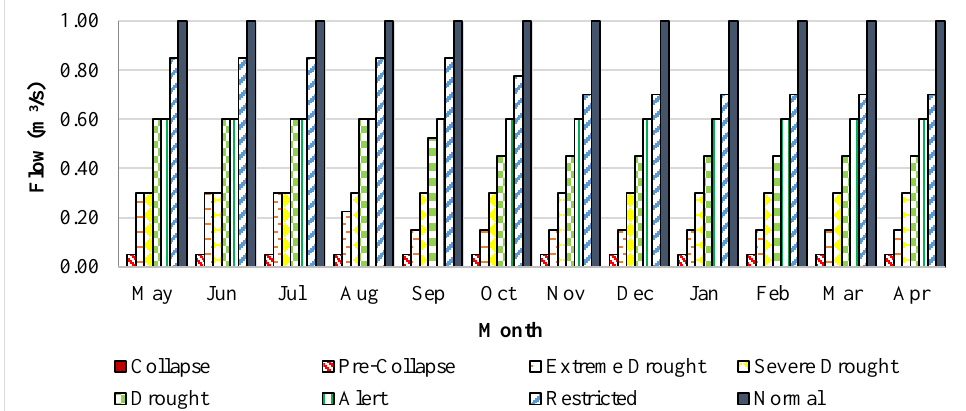
Figure 4. Flow distribution related to the month and water accumulation scenario in the Prata res- ervoir.